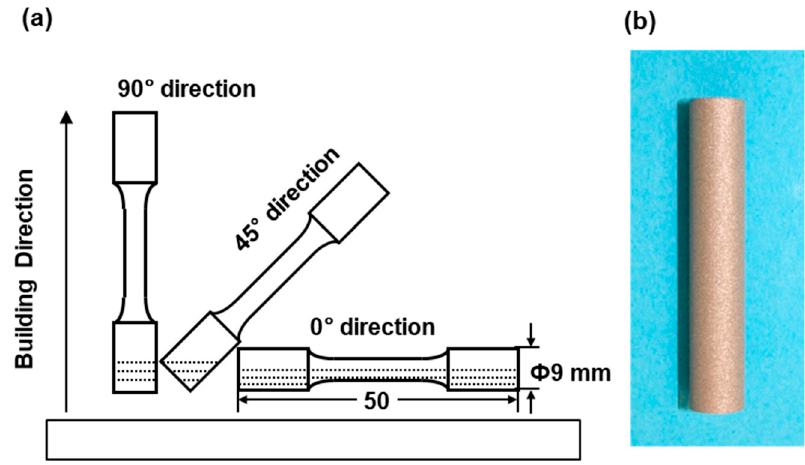
Figure 1. ( a ) Building directions of cylindrical specimens in laser sintering; ( b ) laser-sintered cylindrical specimens.